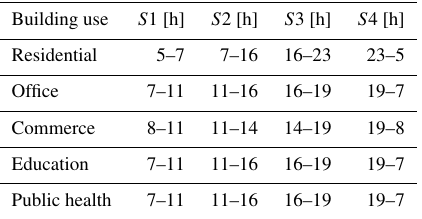
Table A1. Definition of the schedules used to assign the building occupation. A total of four time intervals per day ( S 1 to S 4) are con- sidered. The time period defined for S 4 corresponds to the “night”. The values are in solar time. In France, solar time is 1h (2h) earlier than local time in winter (daylight savings